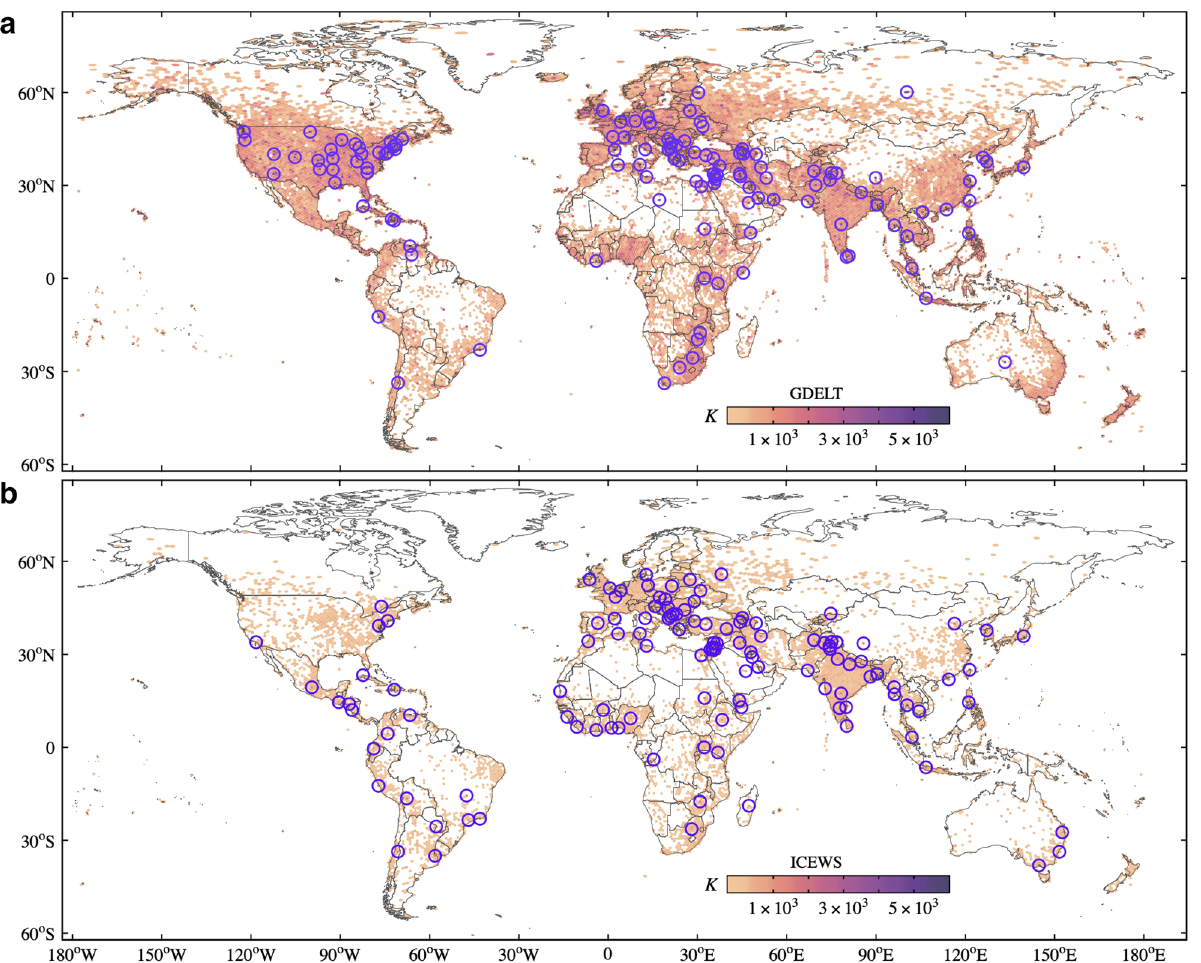
Figure 3. Hubs in the temporal networks. Circles highlight the 120 hubs that correspond to the 99th and 98th percentiles of the highest temporal degrees ( K ) for GDELT and ICEWS, respectively. Maps were generated using R (version 3.6.2) 44 and the ggplot2 (version 3.3.2) 45